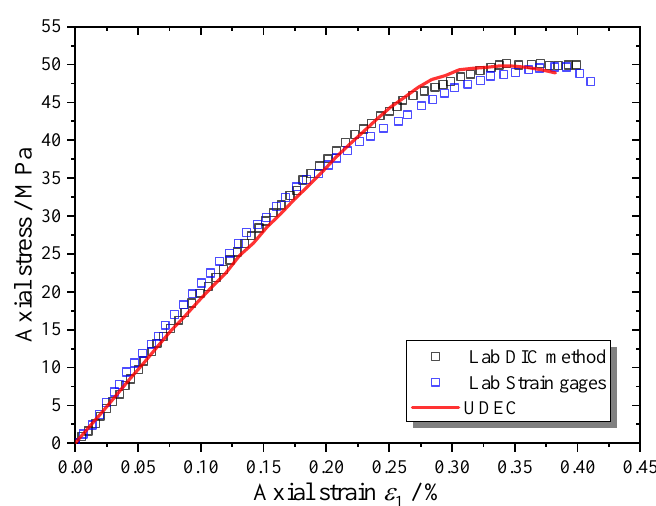
Figure 7. Complete compressive stress–strain curves of CM specimens.